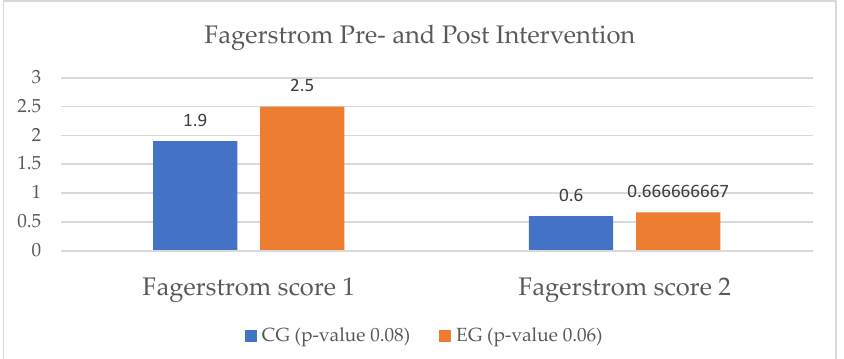
Figure 10. Smoking status of IHD patients. IHD = ischemic heart disease; EG = experimental group; CG = control group; T 0 = before the rehabilitation period; T 1 = after the rehabilitation period .